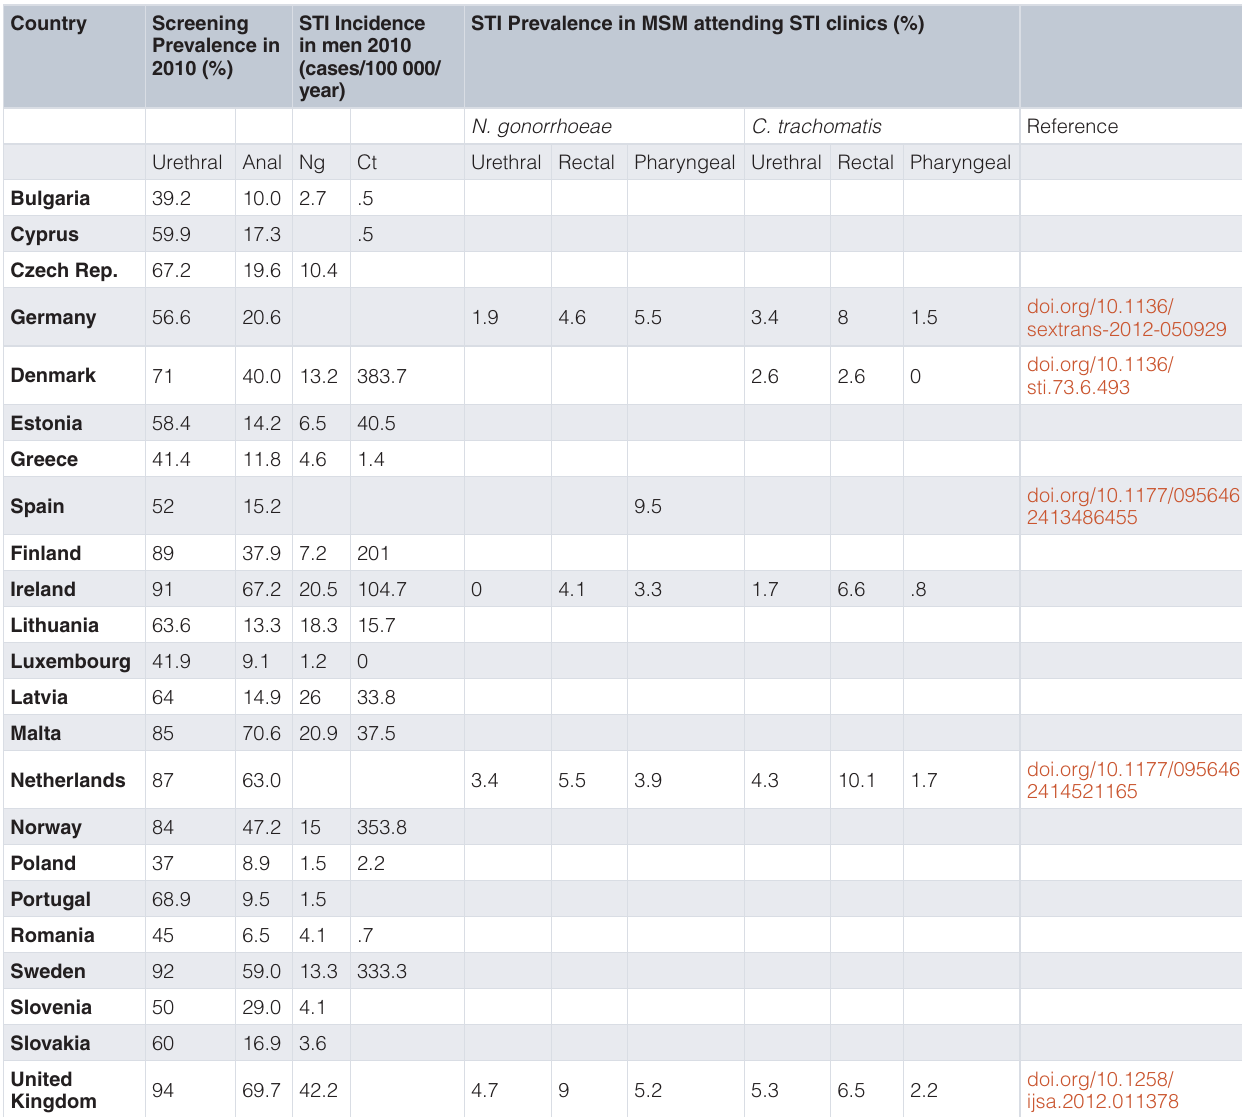
N. gonorrhoeae - Neisseria gonorrhoeae, C. trachomatis - Chlamydia